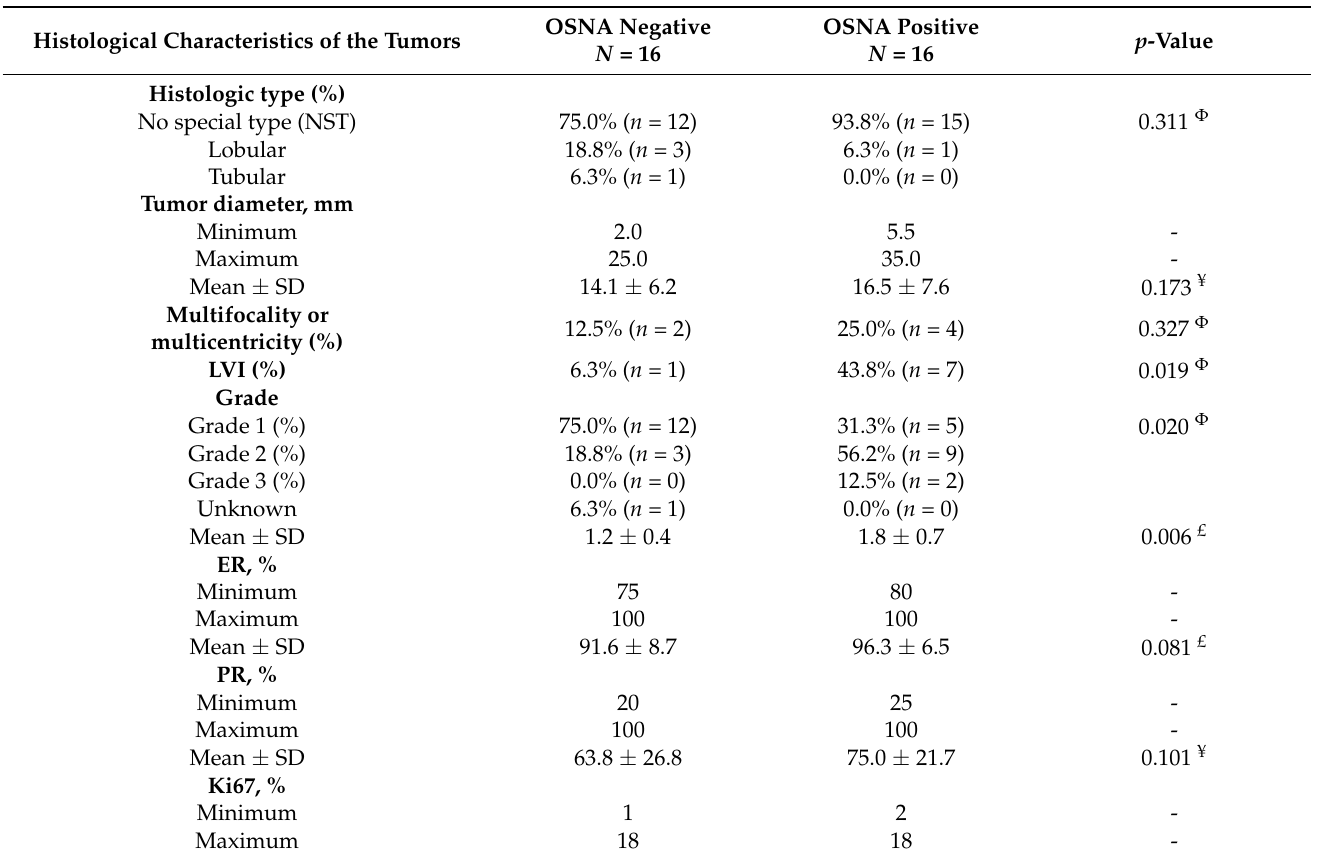
Table 2. Histological characteristics of the tumors, comparing patients with OSNA negative SLNs (pN0) and patients with OSNA positive SLNs (pN1 and